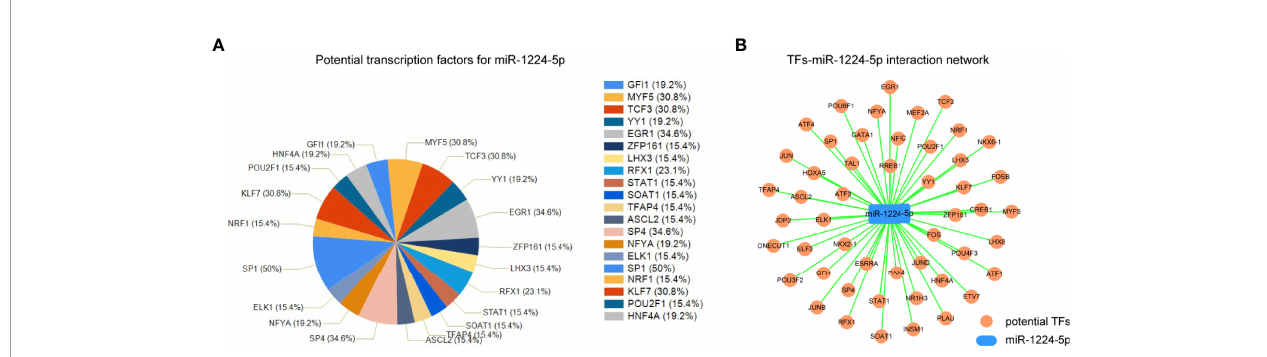
FIGURE 6 | The TFs-miR-1224 interaction network. (A) The potential TFs for miR-1224. (B) The TFs-miR-1224 interaction network. Experiments were repeated three times with three replicates.